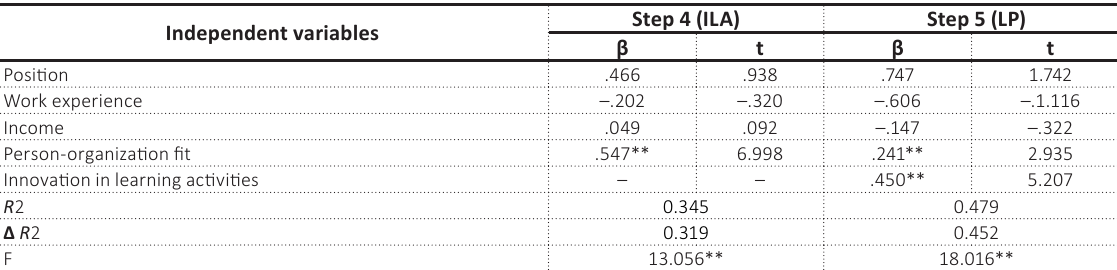
Table 5. Hierarchical regression analysis of person-organization fit (POF) on innovation in learning activities (ILA), person-organization fit (POF), and innovation in learning activities (ILA) on lecturer performance